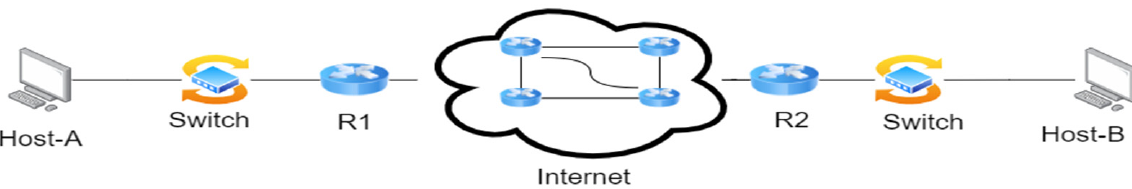
Figure 7. Representation of routing algorithm between sender and receiver in computer network.